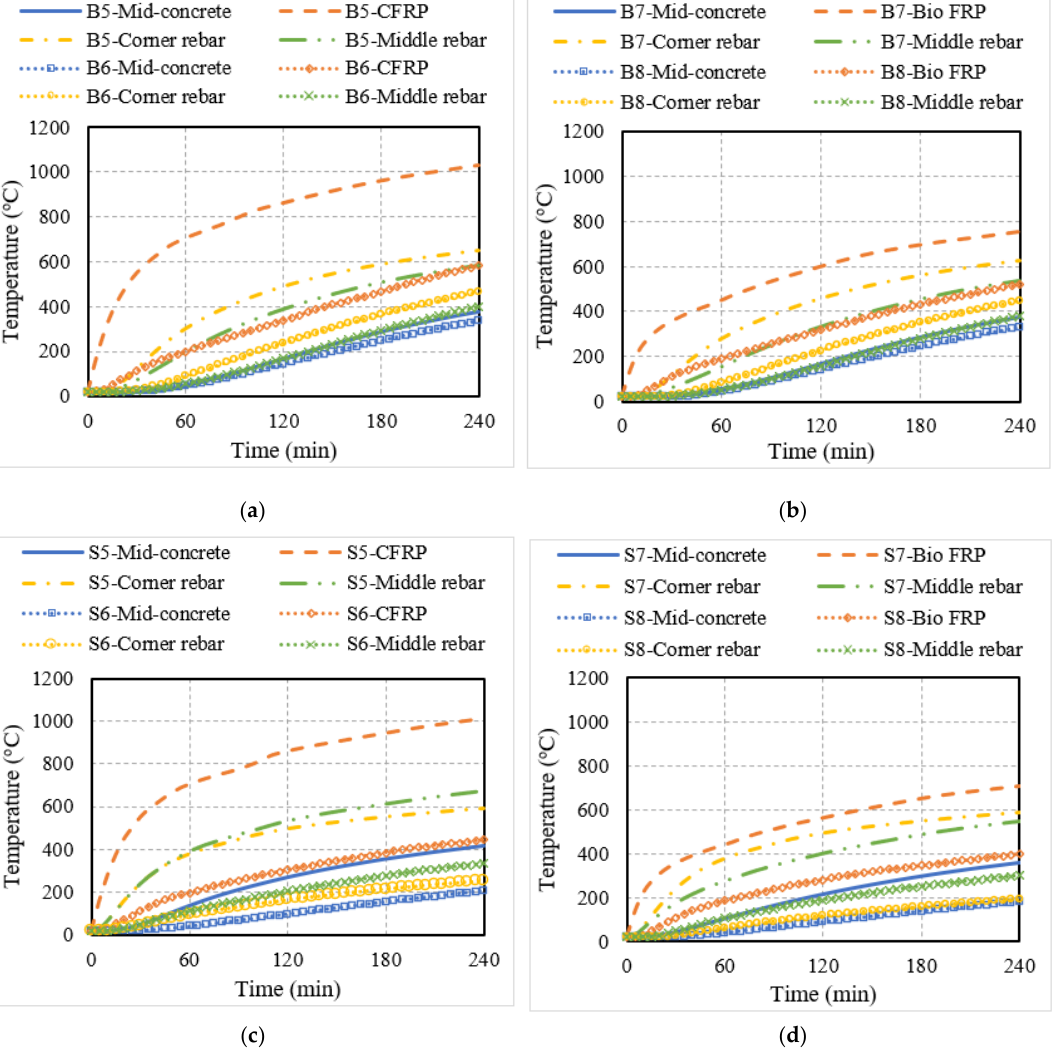
Figure 9. Thermal response of RC members strengthened with conventional or bio-based EB FRP reinforcement. ( a ) EB CFRP-strengthened T-beam; ( b ) EB bio-based FRP-strengthened T-beam; ( c ) EB CFRP-strengthened slab; ( d ) EB bio-based FRP-strengthened slab.